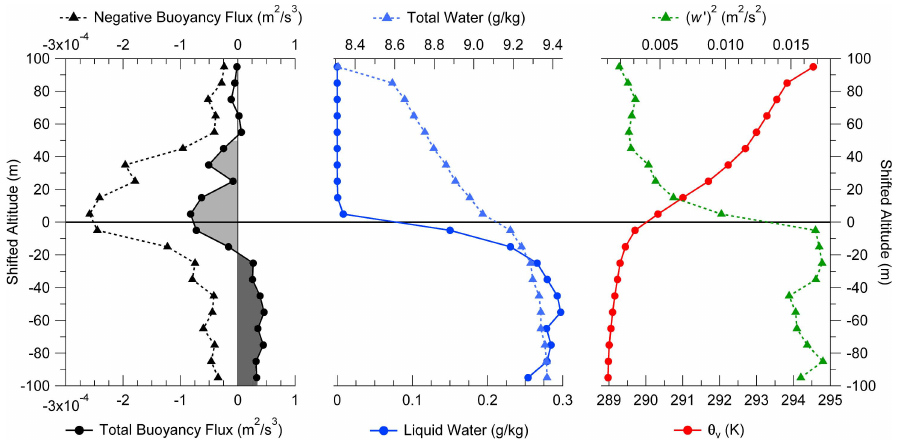
Fig. 4. Whole-flight averaged vertical profiles for 30 July 2008 of (left to right): the sum of only negative buoyancy fluxes; the net buoyancy flux (with altitudes of net negative and positive buoyancy fluxes shaded); total water; liquid water; (cid:0) w 0 (cid:1) 2 ; and virtual potential temperature. The vertical coordinate is the shifted altitude z s where the liquid water cloud top is defined as 0m.